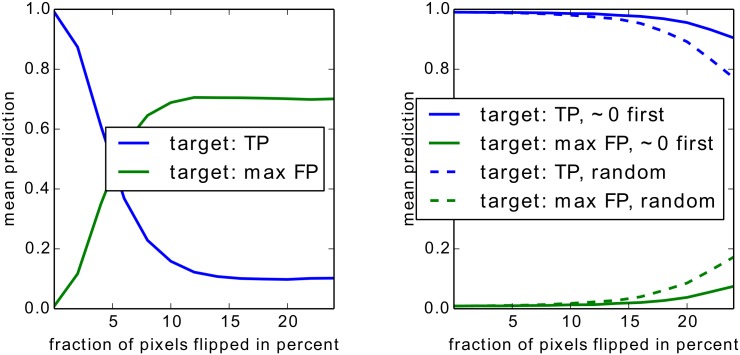
Flipping of pixels for digit and non-digit pixels, compared for each modified digit for the true class against the maximal prediction of all wrong classes.Left: Pixels with highest positive scores are flipped first. Right: Flipping of neutrally predicted pixels, i.e. pixels with absolute value closest to zero are flipped first (solid lines), and flipping of randomly picked pixels (dashed lines). Results are averaged over digits from all digit classes in contrast to using only digit classes 3 and 4 in the preceding figures.